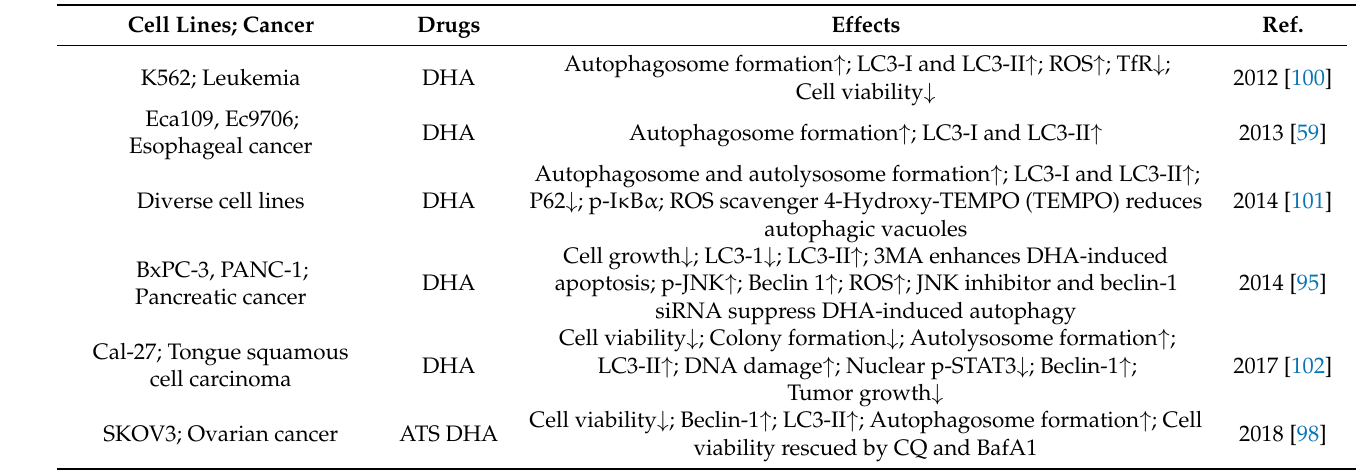
Table 3. List of studies from the last 10 years investigating the effect of ART-type drugs related to autophagy in cancer cells with information on the model systems used, the ART-type drugs tested and the major findings of the